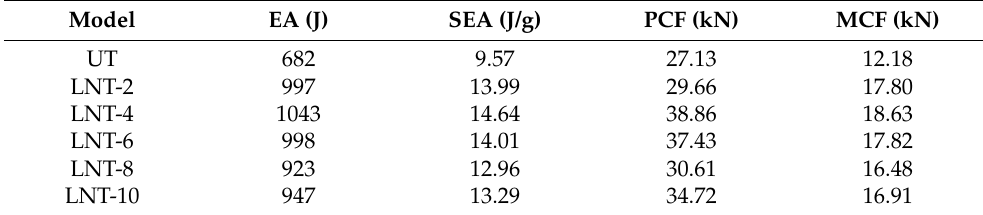
Table 8. Effect of stripes on energy absorption properties.